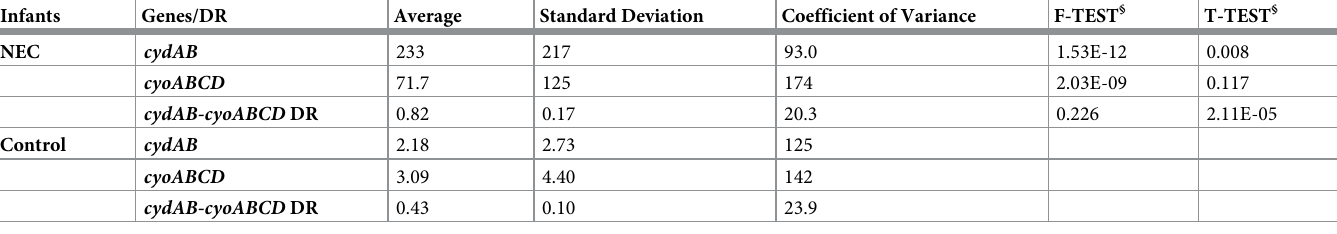
Table 4. Comparison between transcript abundances and diametric ratio (DR) of Escherichia spp. cytochrome oxidases across all time blocks in NEC and control infants.